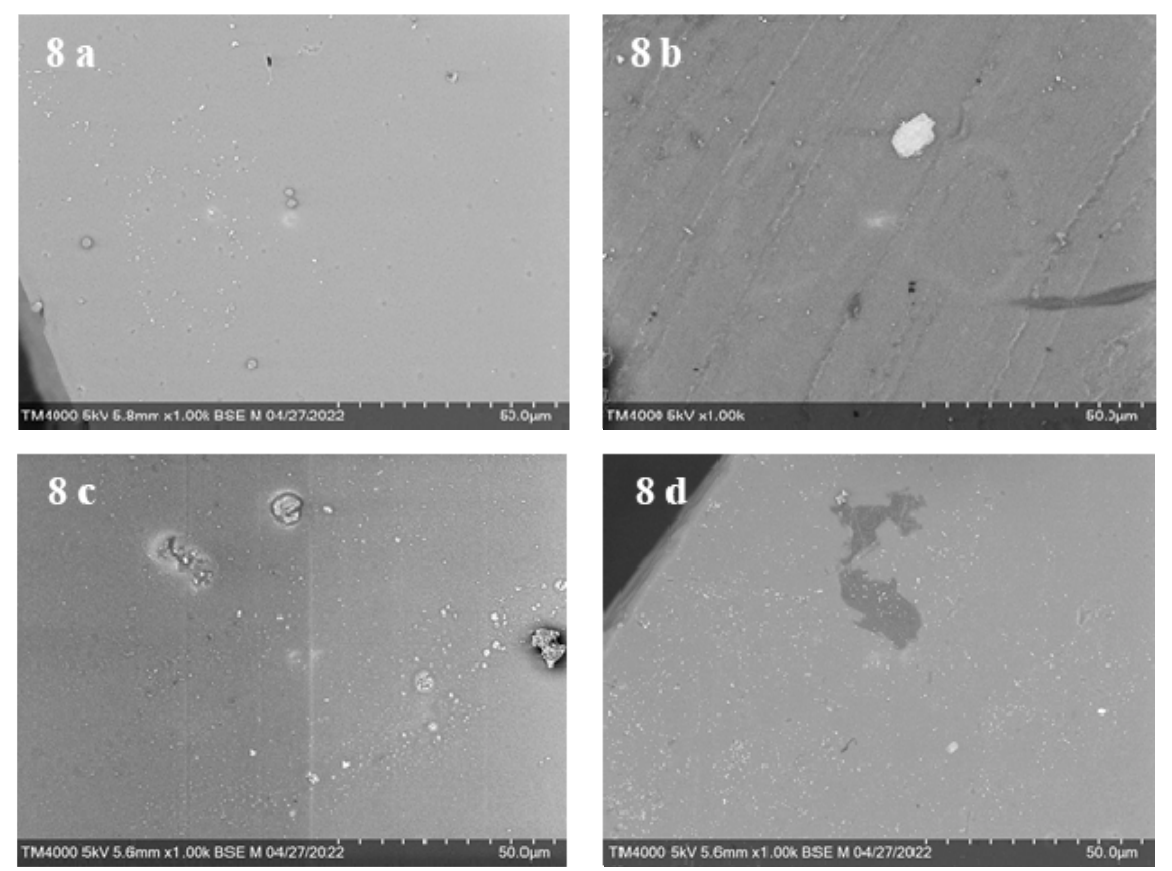
Figure 7. SEM images of polymers 8 a – d at 1.00k